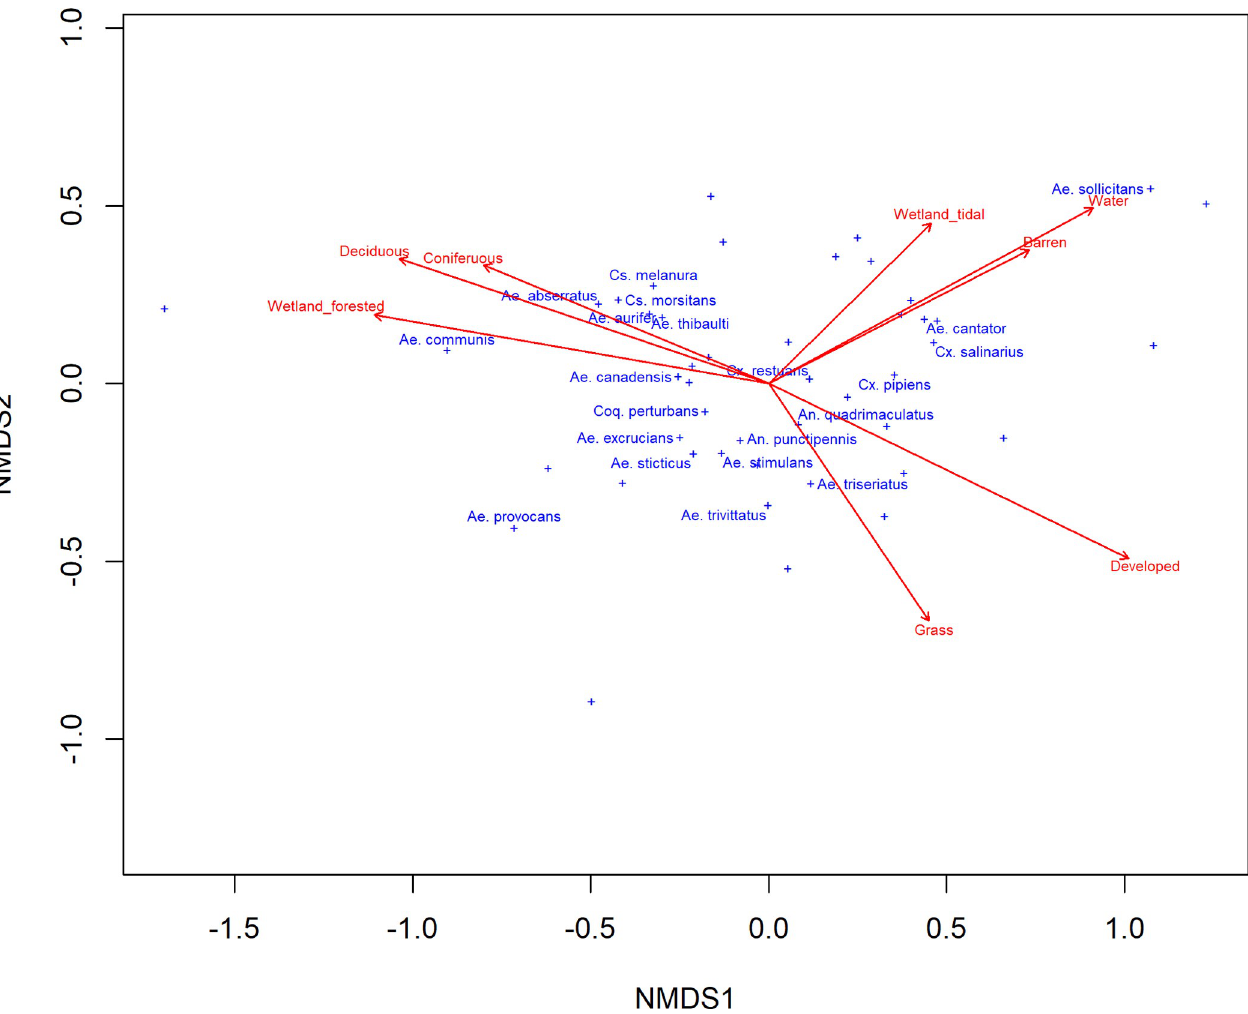
Fig 3. Nonlinear multidimensional scaling plot of the total collection of mosquitoes in light traps at each site across all sampling seasons. Arrows indicate the directional relationship of sites (not shown) and species (blue text and +’s) based on land cover classifications (red text) in the 2.59 km 2 buffer around each site. Only land class variables significant at p = 0.01 are shown, and only the names of the mosquito species which odds of arbovirus detection’s 95% confidence interval were greater than unity are shown. The label for Ae . taeniorhynchus (farthest right cross) has been removed for plotting